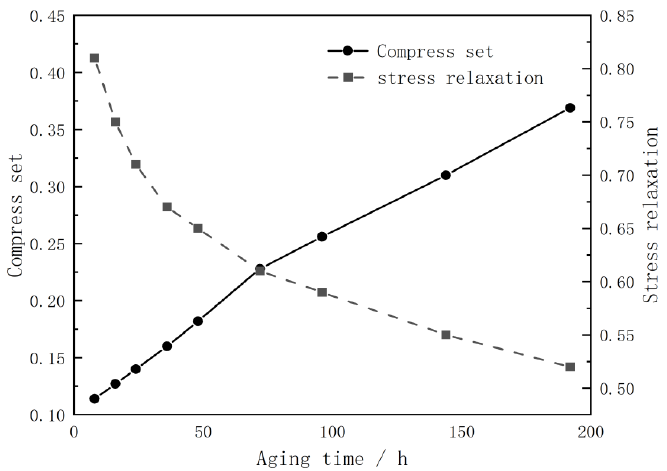
Figure 2. Compress set and stress–relaxation curves for aged silicone rubber foams under thermal conditions of 125 °C.